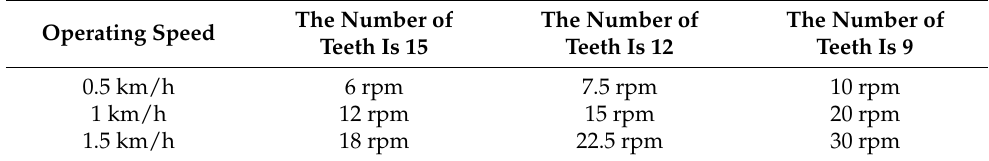
Table 4. The rev of a sucking-seed plate with a different tooth. Operating Speed